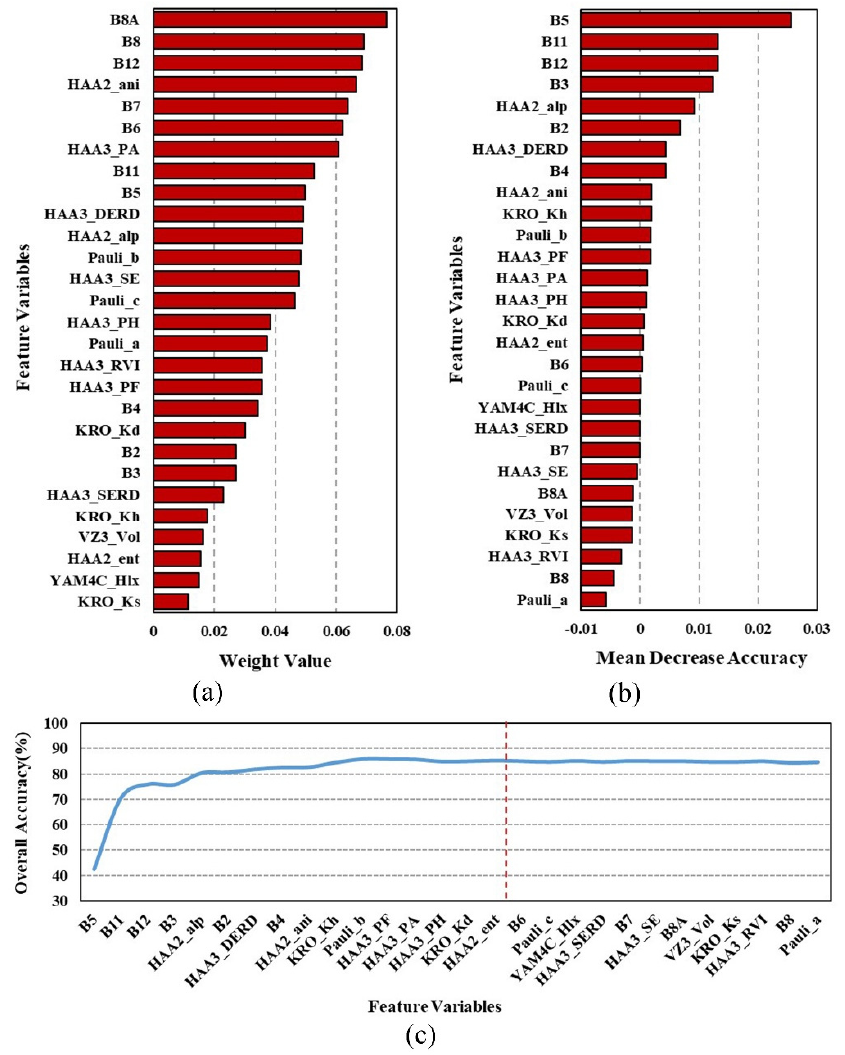
Figure 4. Results of the multisource feature selection by using the ReliefF-RF method. ( a ) The descending rank of the weight value that was calculated by the ReliefF method; ( b ) The descending rank of the mean decrease accuracy that was calculated by the RF method; ( c ) The overall accuracy of the RF model when one feature was added into the model for training per iteration. The red dotted line represents the position of the final determined features.